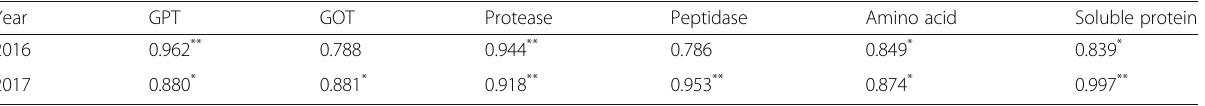
Table 4 Relationship ( R value) between nitrogen metabolic enzyme activity, chemicals and Bt protein concentration in Bt cotton flowers